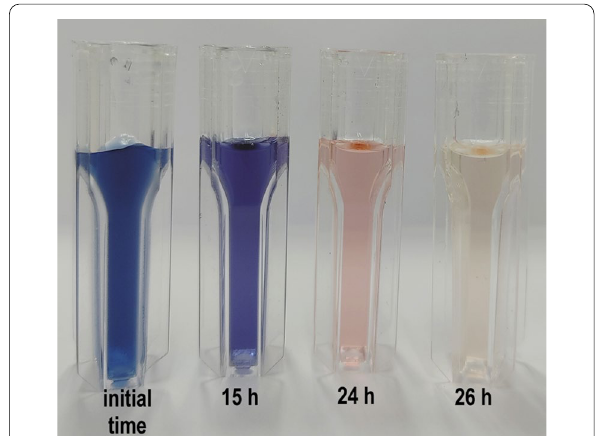
Fig. 1 Different stages of RB-5 removal (100 mg L –1 ) by Candida sake 41E. The figure depicts the sequential shift in the color of the liquid samples upon exposure to the psychrophilic yeast from the starting hue of deep blue through a violet at 15 h to a very light pink at 24 h to finally reach a completely colorless state after a further two